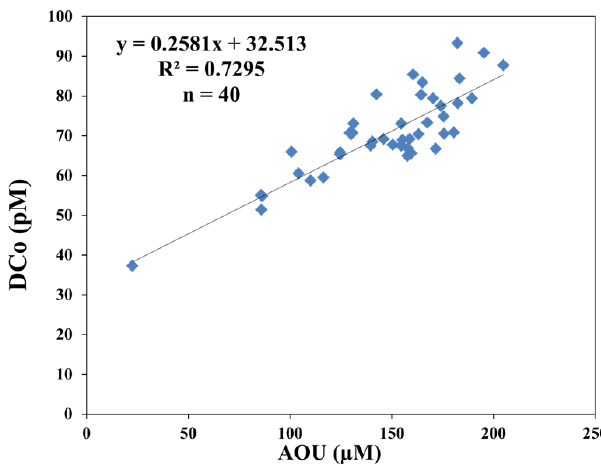
Fig. 8. Relationship among the concentrations of dissolved cobalt ( D Co) and the apparent oxygen utilization (AOU) in the intermedi- ate waters of the equatorial area